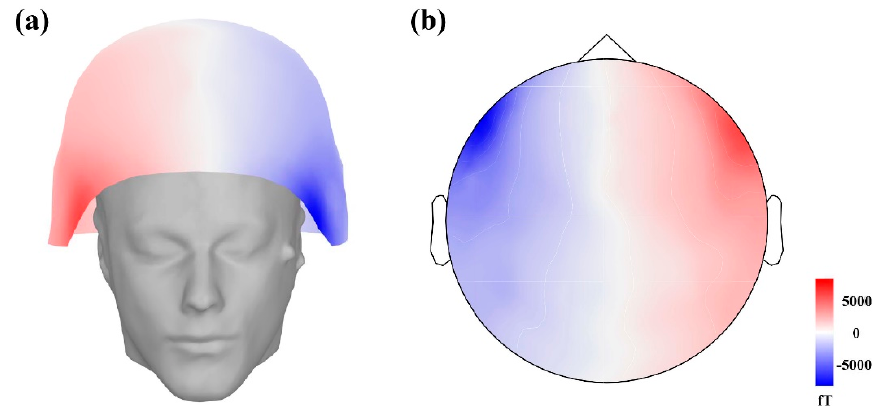
Figure 3. The 3D view display of a sampling signal in which the signal amplitude is color-coded ( a ) and is plotted on a 2-dimensional plane ( b